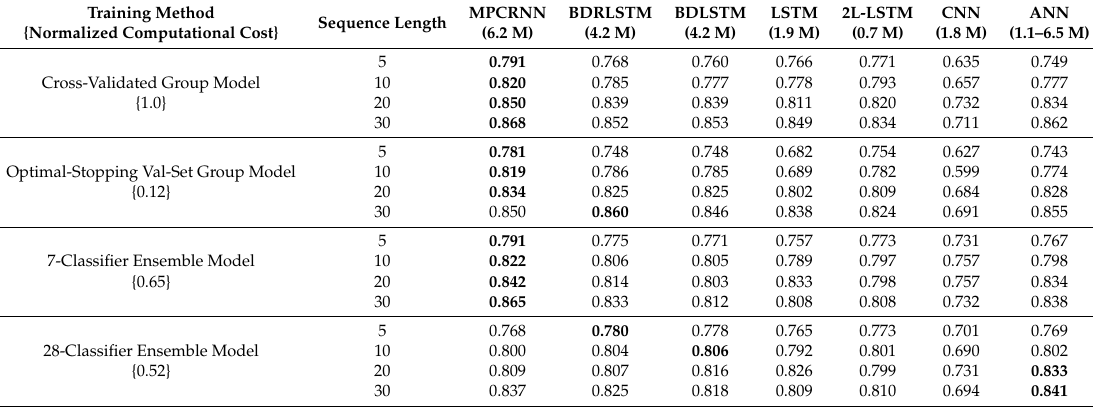
Table 2. Mean classification accuracy across participants for a given training method, sequence length, and architecture. Number of parameters per model is displayed below each neural network architecture. Measured computational costs normalized to the cross-validated group model are displayed below each cross-participant training method. The best performing architecture for each training method and sequence length is shown in bold